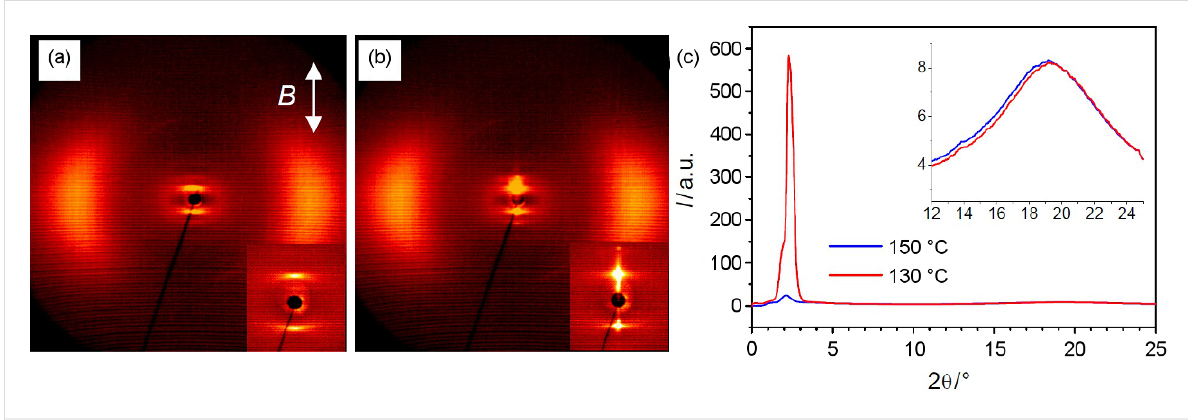
Figure 3: XRD data of the dimesogen CB-Ox/4 : (a,b) diffraction patterns of a magnetic-field-aligned sample (the direction of the magnetic field is shown as a white arrow), the insets show the scattering in the small-angle region: (a) N cybA at 150 °C; (b) CybA at 130 °C; (c) θ -scans at 150 °C and 130 °C in the small-angle regions of both the N cybA and the CybA phase.